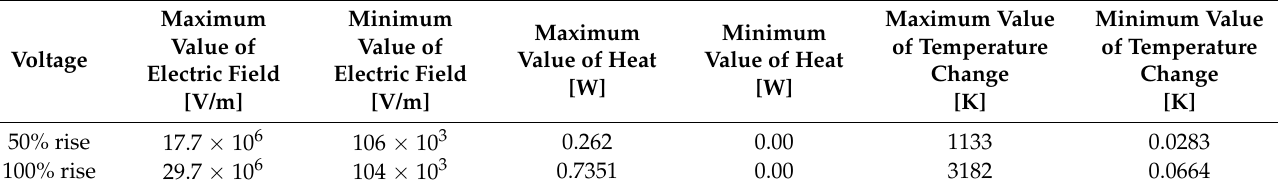
Table 6. Maximum and minimum values for each